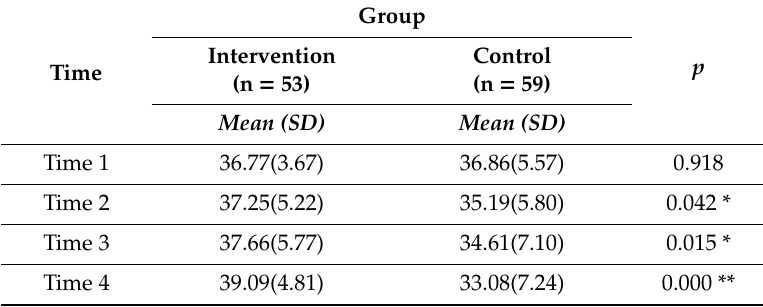
Table 2. Comparison of the spiritual well-being scores between the intervention (n = 53) and control (n = 59) groups classified by time point.